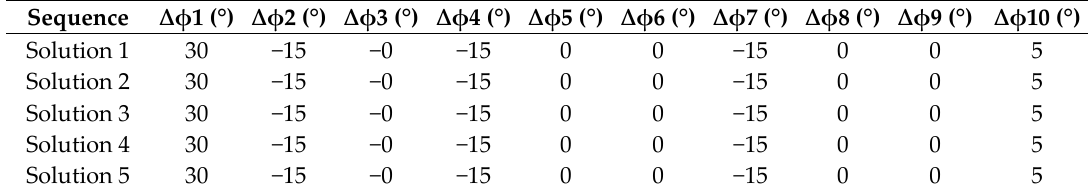
Table 9. Optimal solutions in a large angle crossing situation.